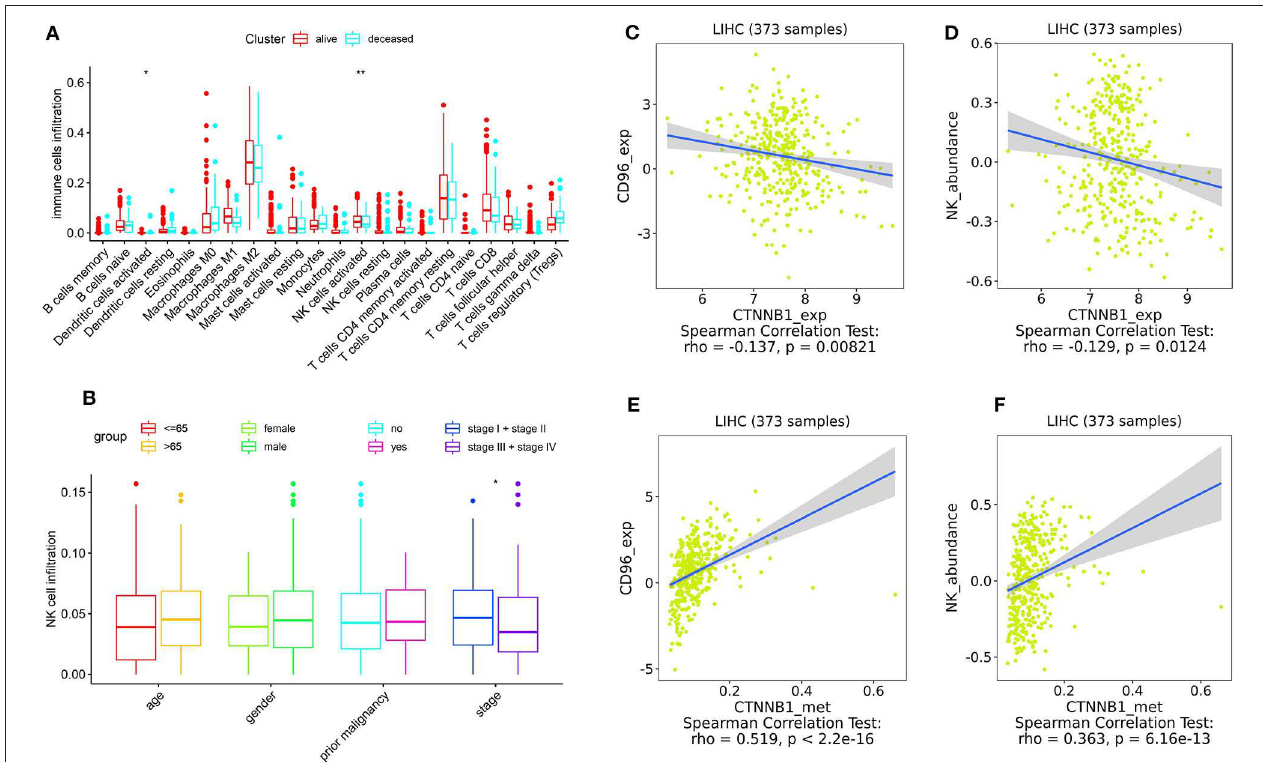
FIGURE 7 | Correlation analysis. (A) The correlation between 22 types of immune cells and survival. (B) The correlation between NK cells and clinical parameters. (C,D) The correlation between CTNNB1 expression and CD96, and NK cells, respectively. (E,F) The correlation between CTNNB1 methylation and CD96, and NK cells, respectively. Notes: “*” in the plots means P < 0.05, “**” means P <